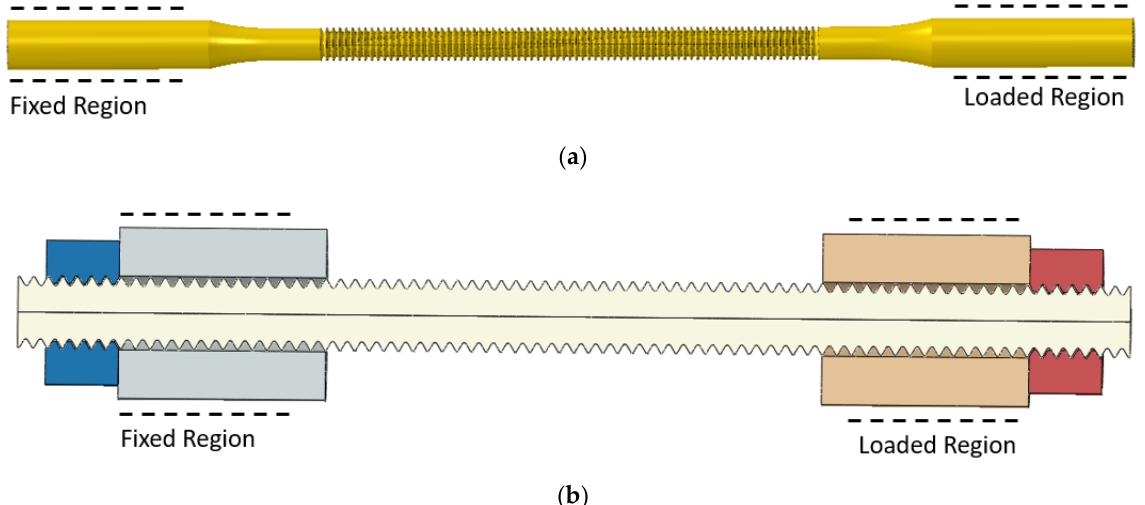
Figure 4. Regions attached to the wedge grip system ( a ) threaded specimen ( b ) stud specimen.